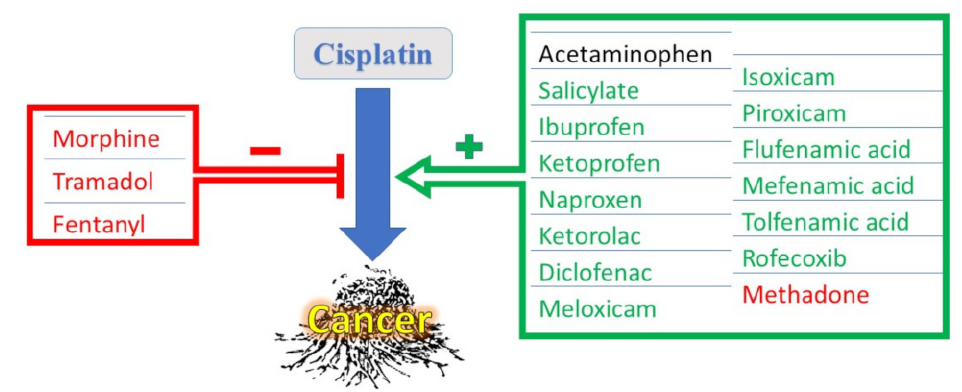
Figure 2. Effect of different analgesics on cisplatin’s anticancer efficacy. Analgesic names in green letters are non-steroidal anti-inflammatory drugs and those in red letters are narcotic